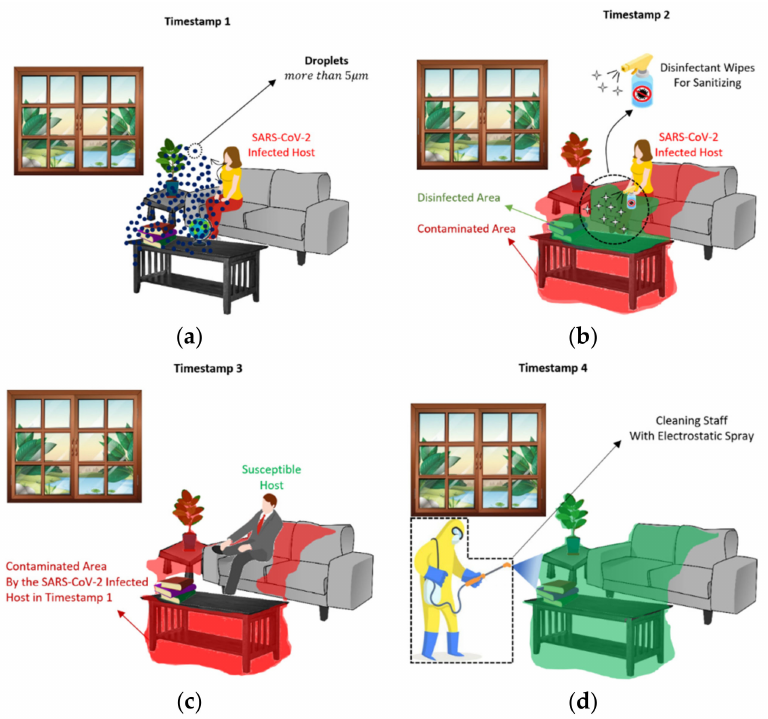
Figure A1. The impact of disinfecting activities to prevent further spread of the SARS-CoV-2 virus: ( a ) Showing transmission of SARS-CoV-2-laden droplets caused by an infected host; ( b ) Showing possibly contaminated surfaces in the immediate vicinity of the infected host and disinfected areas after sanitizing; ( c ) Showing objects that are still contaminated and allow the susceptible host to be exposed by the virus, and ( d ) Showing disinfected area after sanitizing contaminated objects by cleaning